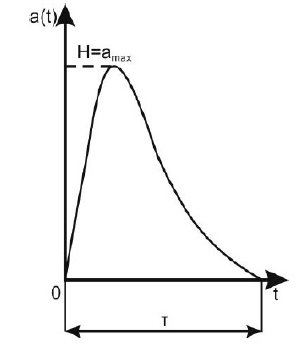
Figure 7. Graphical representation of the shock pulse.